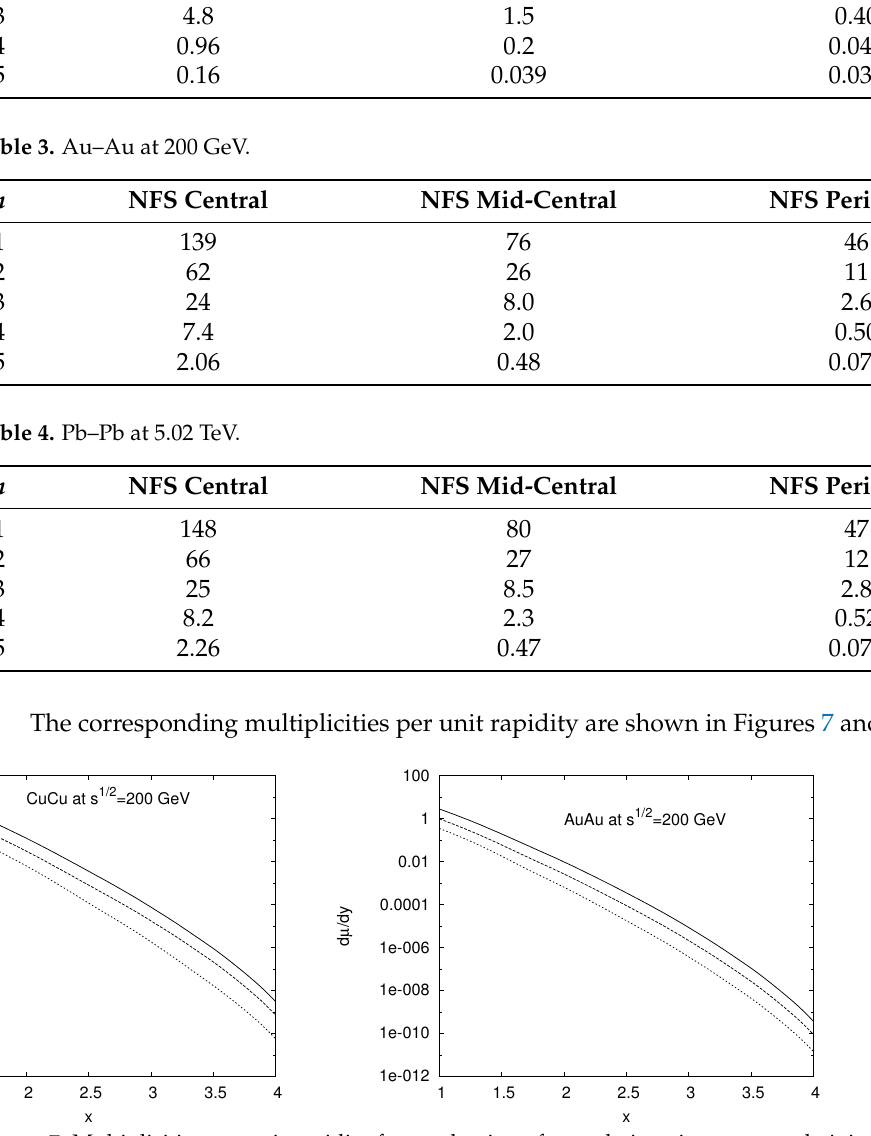
Figure 7. Multiplicities per unit rapidity for production of cumulative pions at cumulativity x ≥ 1 in the central (upper curve), mid-central (middle curve), and peripheral (lower curve) regions in Cu–Cu and Au–Au collisions at 200